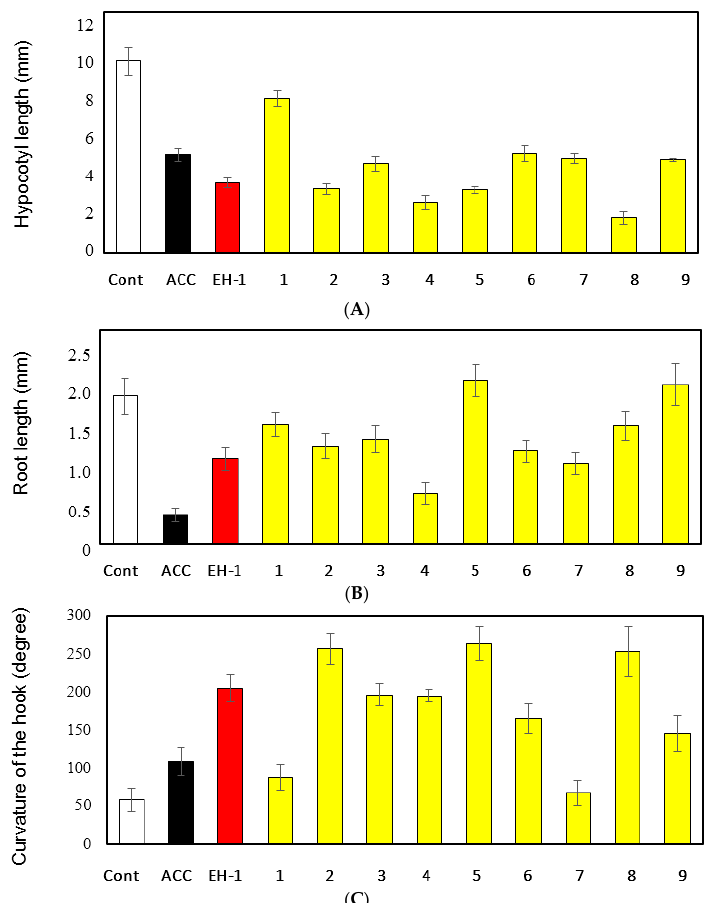
Figure 2. Effect of EH-1 and its analogues on inducing morphology typical of triple response in Arabidopsis seedlings. The triple responses of Arabidopsis seedlings were measured by determining the hypocotyl length, root length and curvature of the hook. Approximately 50 seeds/well of Arabidopsis were grown for five days in the dark in a 24 well plate on medium containing ½ MS and the concentration of the test compounds including ACC and EH-1 are set at a final concentration of 10 μ M. ACC was used as a positive control while using DMSO mock treatment as a control. The chemical structures of the test compounds (in number) were as shown in Table 1. ( A ) Effect of sulfonamide derivatives on hypocotyl elongation; ( B ) Effect of sulfonamide derivatives on root growth; ( C ) Effect of sulfonamide derivatives on inducing exaggerated apical hook of Arabidopsis seedlings were measured by determine 11 seeds. Data are the means ± s.e. obtained from 11 to 15 plants. All the experiments were done three times to establish the repeatability.